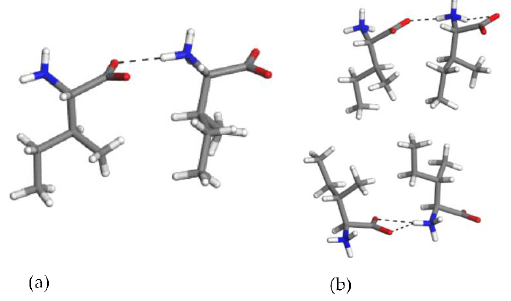
Figure 1. ( a ) Asymmetric unit of form A, forming dimer interactions, and ( b ) the asymmetric unit arrangement of the form B polymorph, consisting of four molecules in an asymmetric